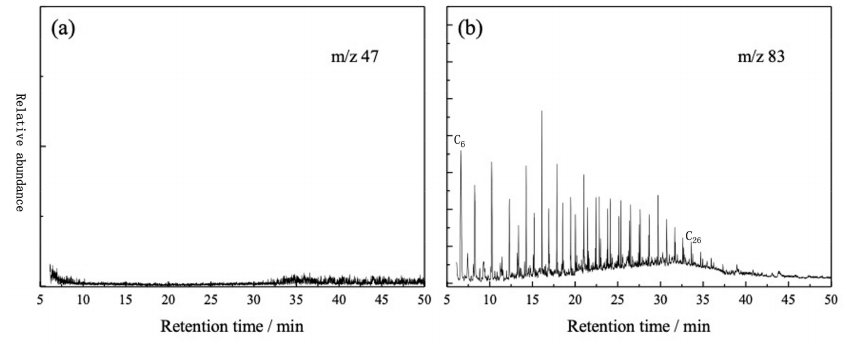
Figure 7. Spectrum of sulfur compounds. ( a ) The ion current spectra with m / z of 47;( b ) The ion current spectra with m / z of 83.